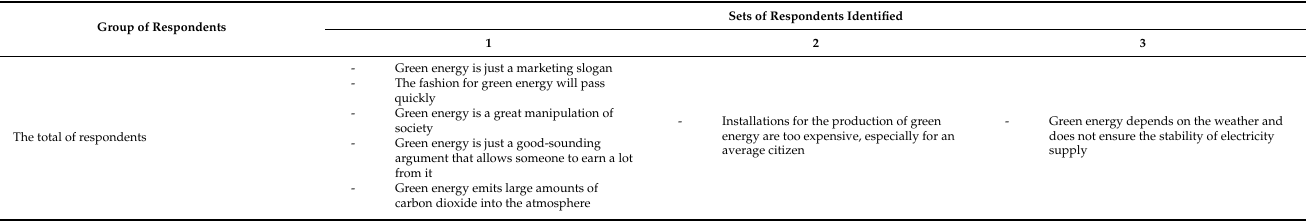
Table 10. Sets of respondents identified on the basis of the level of their market awareness of green energy according to the self-assessment of the level of knowledge about green energy and the importance assigned to the sources of energy